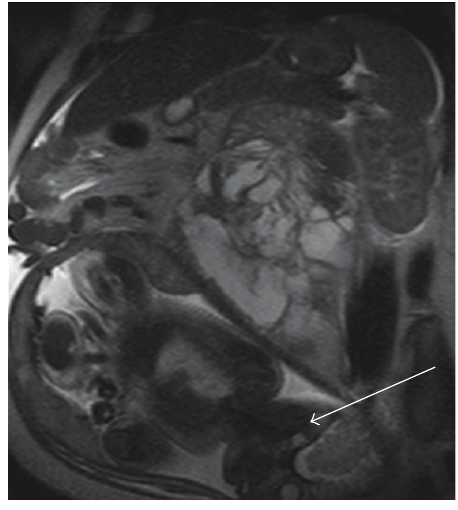
Figure 2: MRI abdomen, arrow pointing to gravid